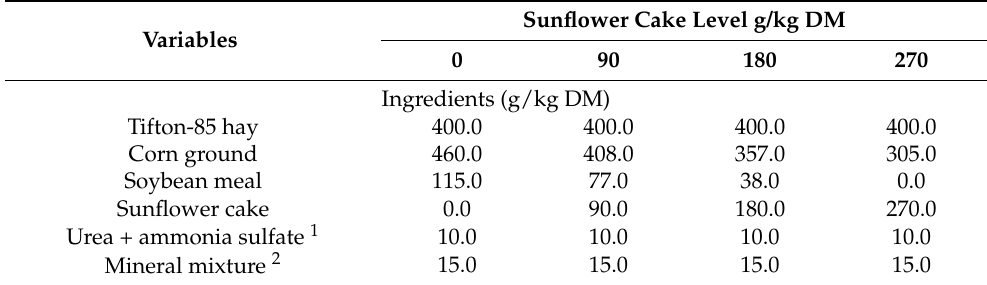
Table 2. Ingredient proportions and chemical composition of the experimental